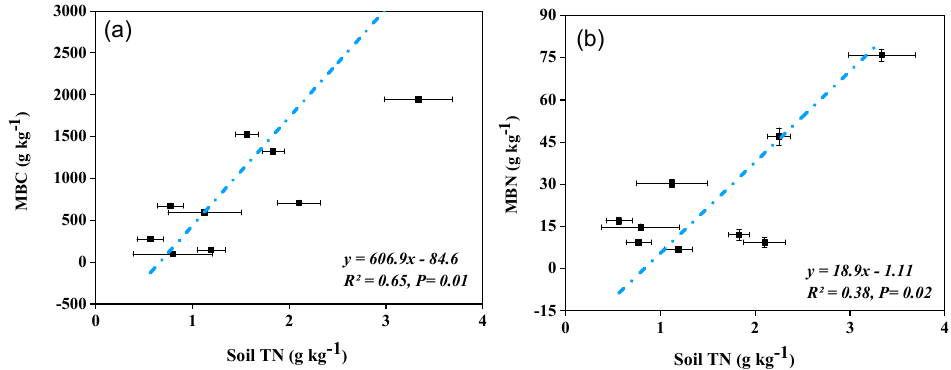
Figure 4. A linear relationship between soil total nitrogen (TN) and ( a ) soil microbial biomass carbon (MBC), and ( b ) soil microbial biomass nitrogen (MBN) across the soil depths and sub-tropical forest types in northeastern Hunan province, south central China.